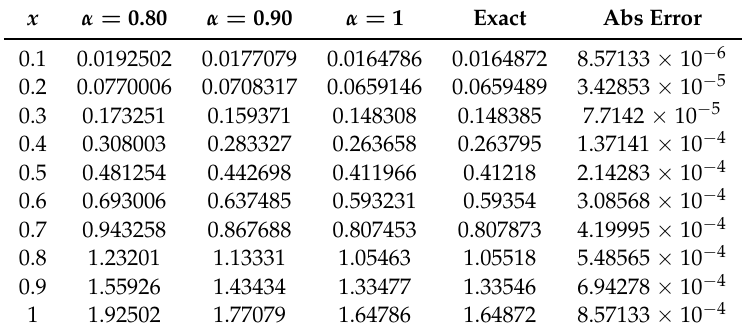
Table 8. Third order approximate results for different values of α at t = 0.50 of Example 2.